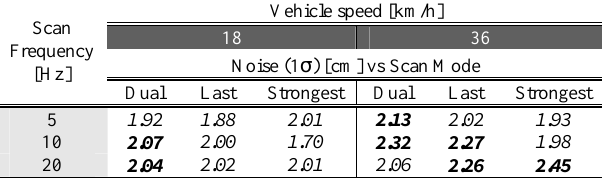
Table 6: Noise in cm on Nadir range at 4 m vs. scan mode, frequency and vehicle speed.